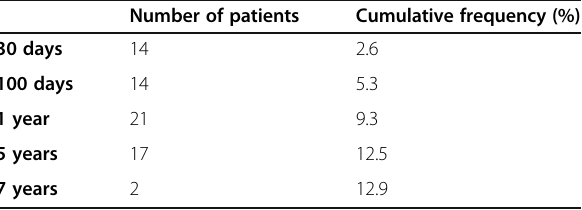
Table 2 Cumulative frequency of CNS complications along the follow-up